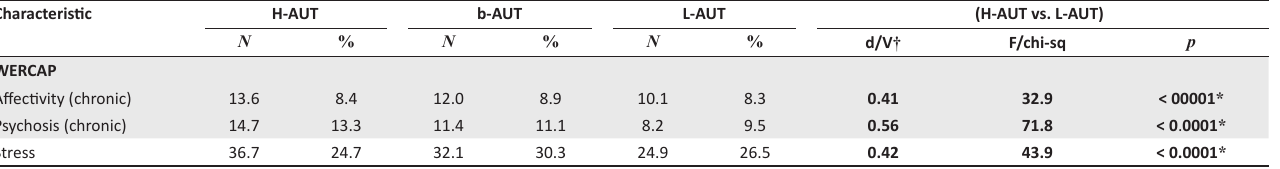
TABLE 3: Clinical characteristics of participant groups ( N = 8918).